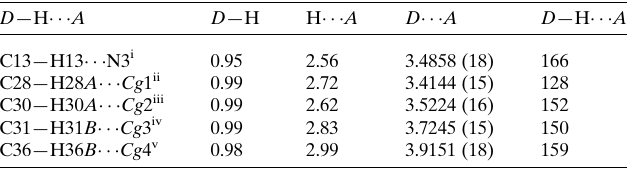
Table 1 Hydrogen-bond geometry (A˚ , (cid:3)